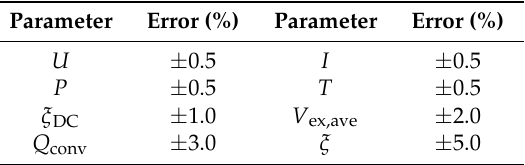
Table 1. The errors of the measured parameters.